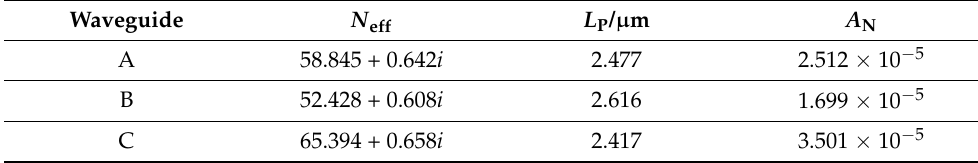
Figure 8. Comparison of three SGPWGs. ( a ) Cross-section of Waveguide A ( R = a = 50 nm), B ( a = 50 nm, b = 150 nm), and C ( R = b = 150 nm); ( b ) 2D energy density distributions of ( a ).